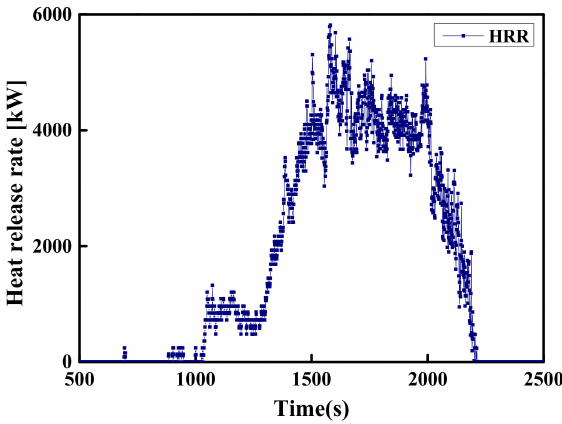
Figure 6. The HRR with a car as a fire source.